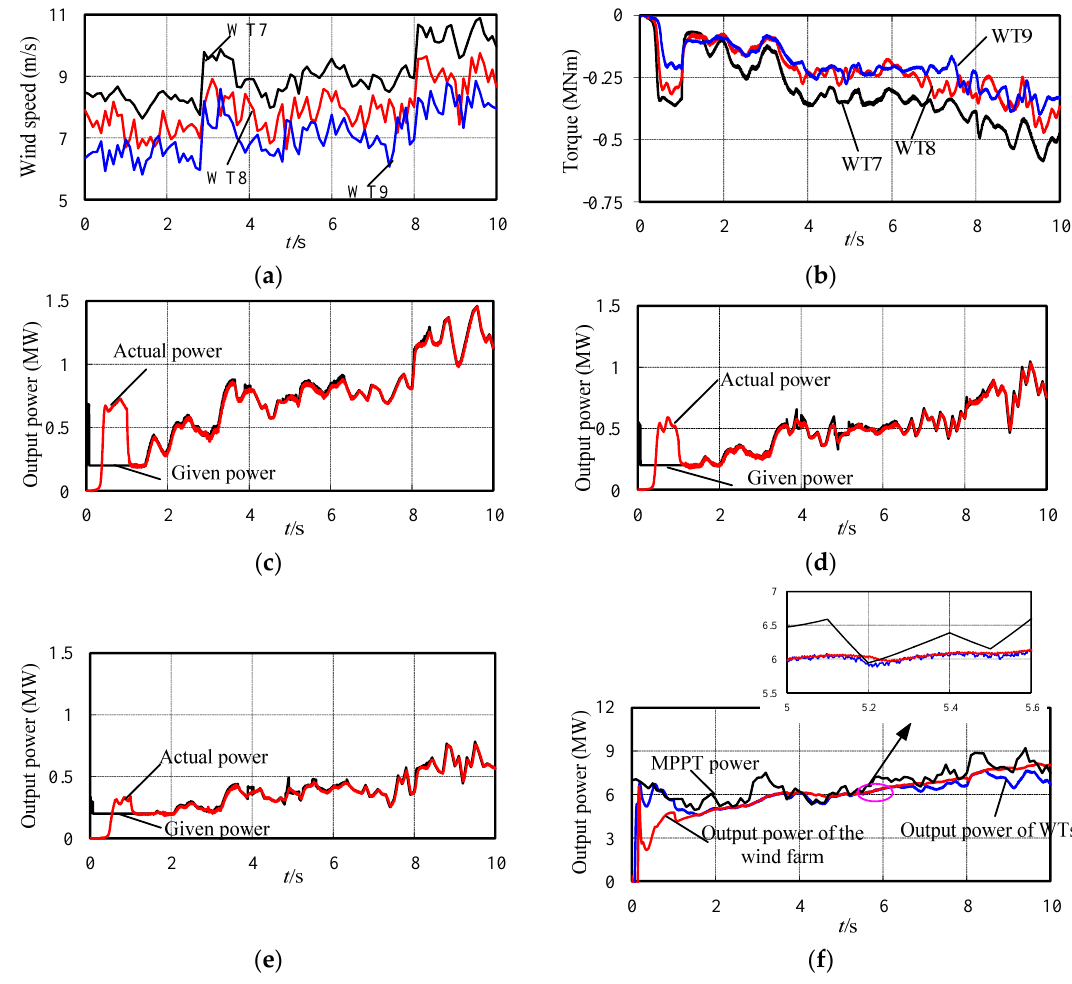
Figure 14. Time histories of the wind farm when the wind speed condition of CWTs is changed. ( a ) wind speed of CWTs. ( b ) Rotor torque of CWTs. ( c ) Output power of CWT (WT7). ( d ) Output power of CWT (WT8). ( e ) Output power of CWT (WT9). ( f ) Total output power of the wind farm.